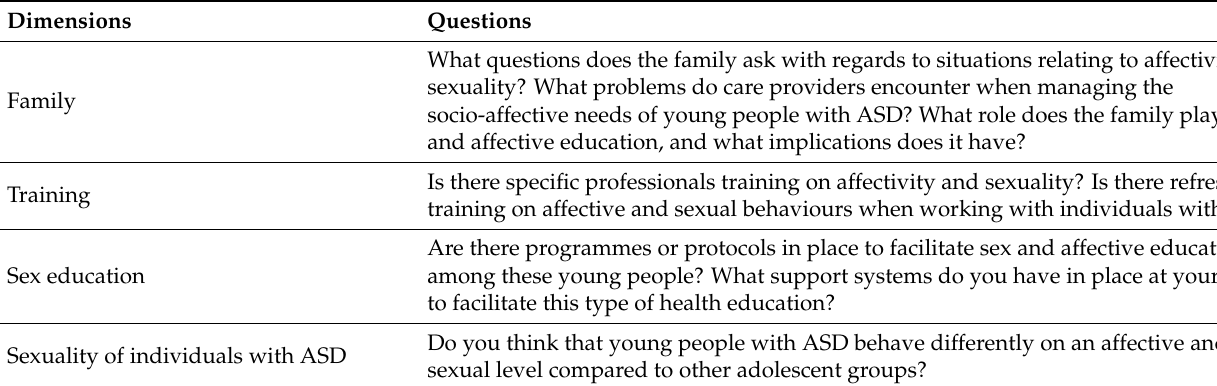
Table 2. Dimensions and associated